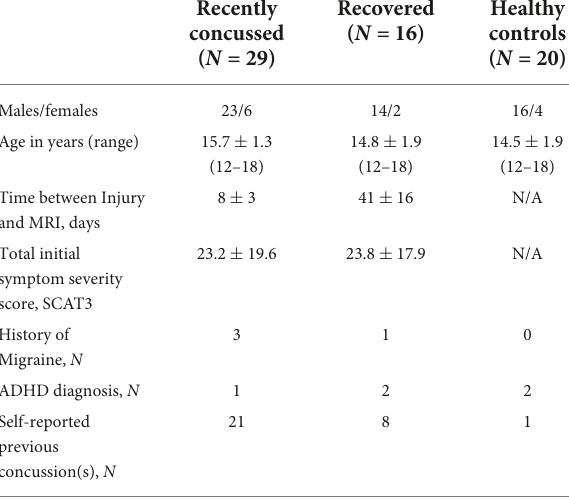
TABLE 1 Summary of subject demographics. Groups did not significantly differ by age and initial symptom severity